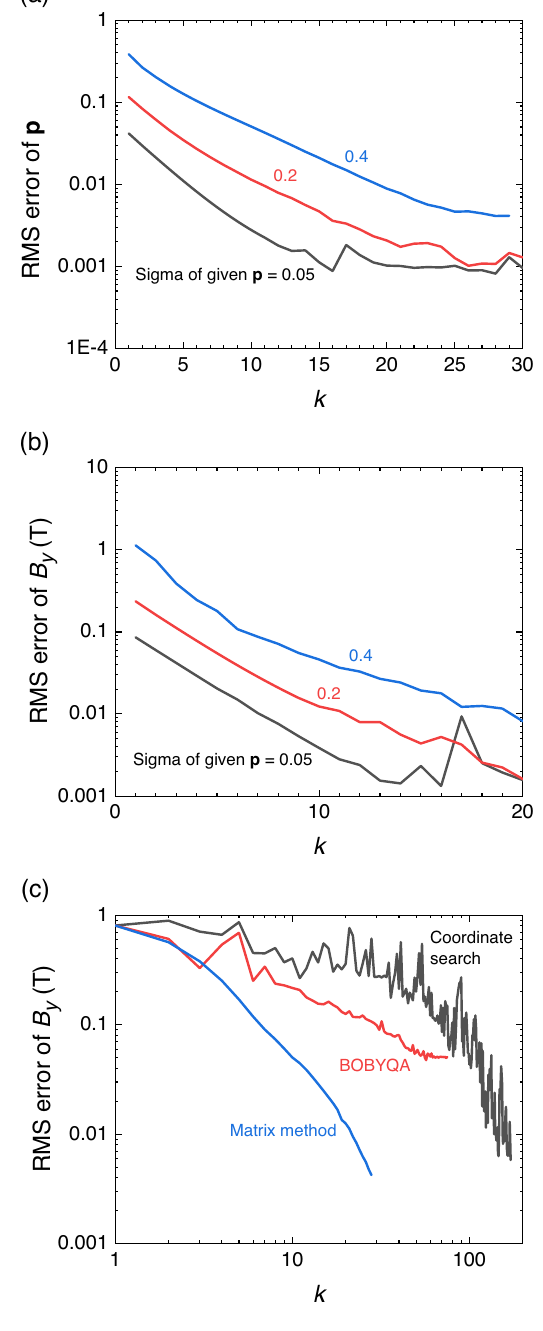
FIG. 6. RMS difference of (a) given and estimated p and ¼ 0 . 05 , 0.2 and 0.4. (c) Com- (b) input and output B , for σ y p parison of the conversion of the matrix method with the general- purpose optimization